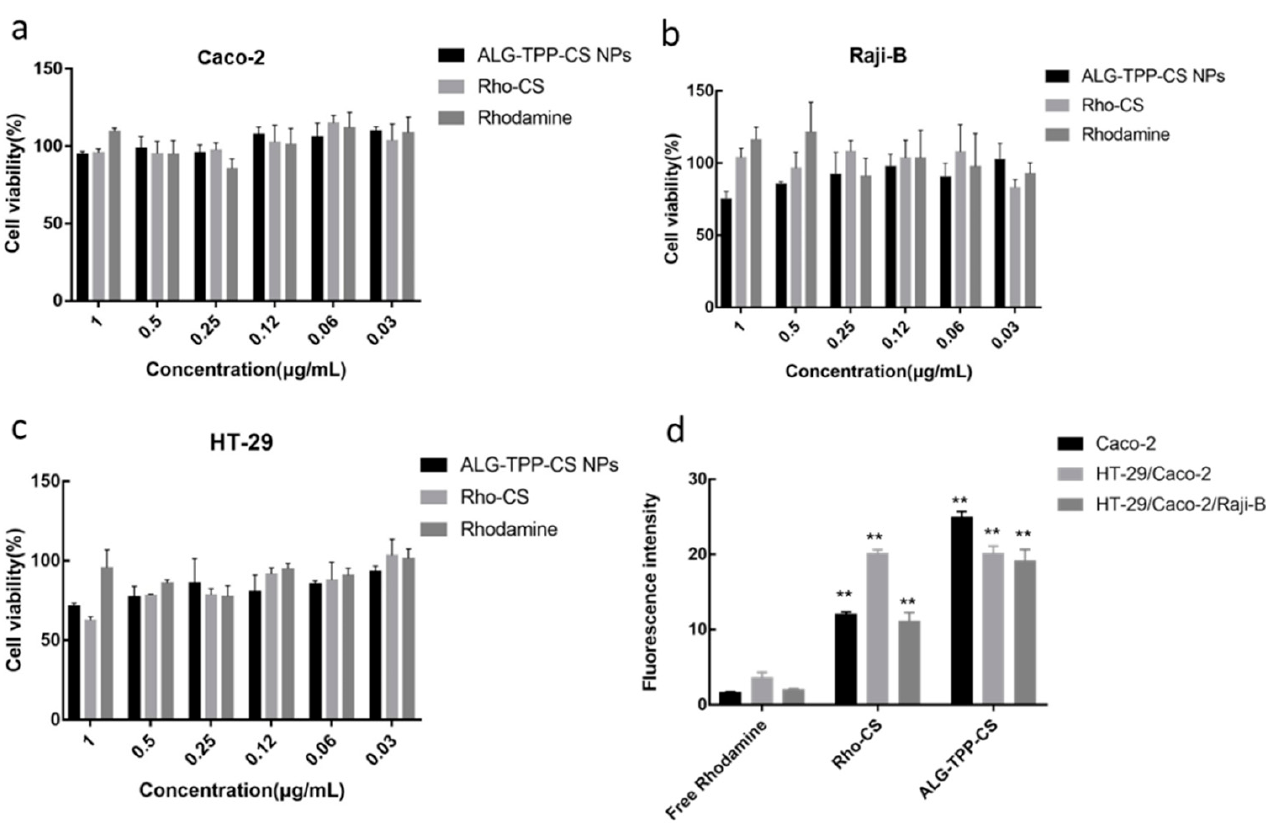
Figure 2. ( a – c ) The cytotoxicity of Rhodamine B, Rho-CS and Rho-CS-TPP-ALG NPs in Caco-2 ( a ), HT-29 ( b ) and Raji-B ( c ) cells. ( d ) Cellular uptake of Rhodamine B, Rho-CS and Rho-CS-TPP-ALG NPs in Caco-2, Caco-2/HT-29, Caco-2/HT-29/Raji-B cells. ** p < 0.01 ( n = 3), VS Rhodamine